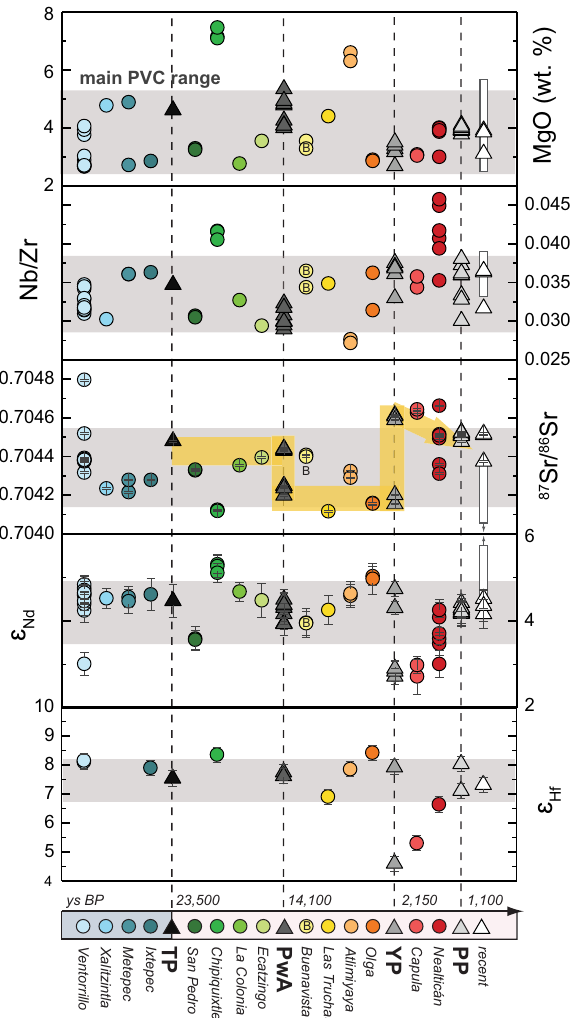
Figure 8: Temporal evolution of geochemical charac- teristics of the Ventorrillo and Popocatépetl volcanic edifices. Grey bands denote long-term compositional ranges for the majority of eruptions at the PVC, referred to hereafter as the ‘main PVC range’. Yellow trend high- lights systematic changes in Sr isotope compositions in lavas and pumices, related to reconfigurations of the plumbing system caused by the PwA and YP Plinian eruptions. White boxes denote data for present-day ac- tivity from Straub and Martín-Del Pozzo [2001]; Schaaf et al. [2005]; Witter et al. [2005]; and Torres-Alvarado et al. [2011]. See text for further explanation.